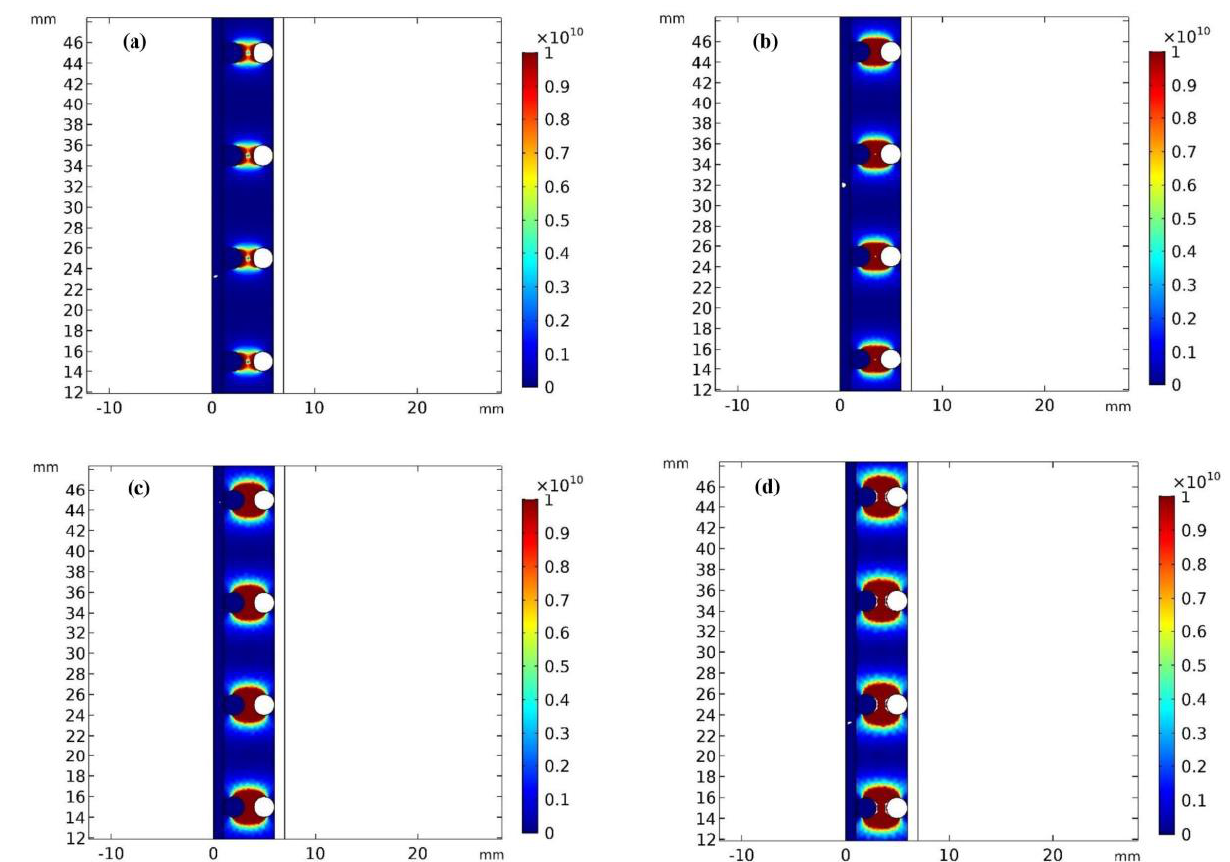
Figure 5. DEP force field ( ∇ |E| 2 ) using electrode spacing of 0.5 cm and different applied currents: ( a ) 200 mA, ( b ) 400 mA, ( c ) 600 mA and ( d ) 800 mA.